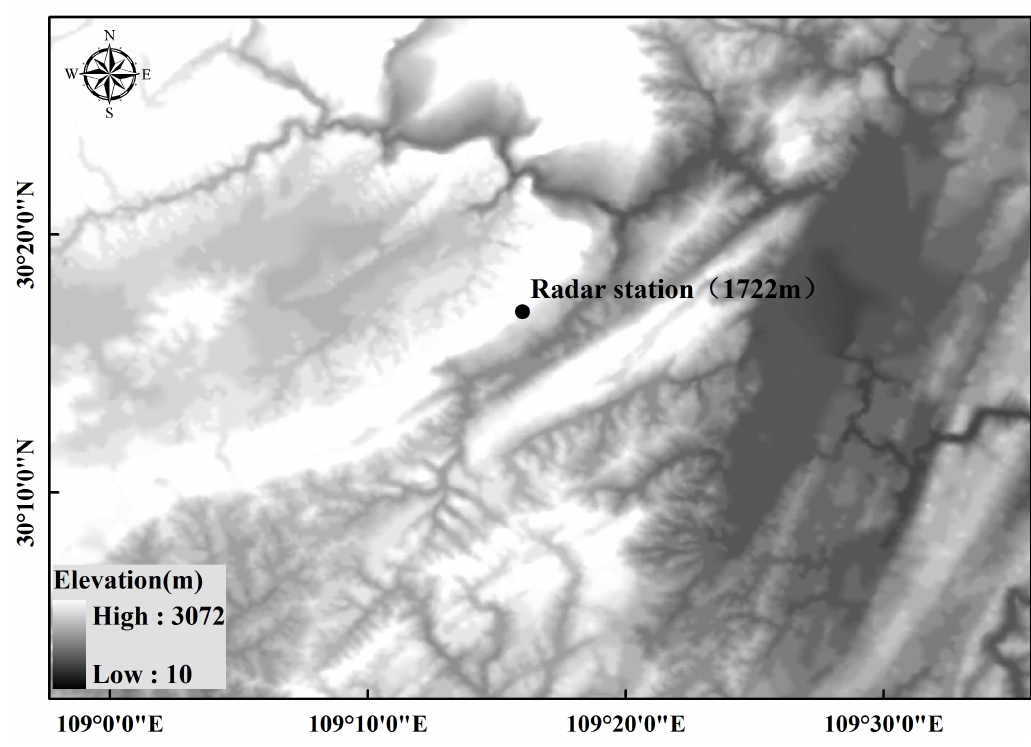
Figure 1. Map of the observation